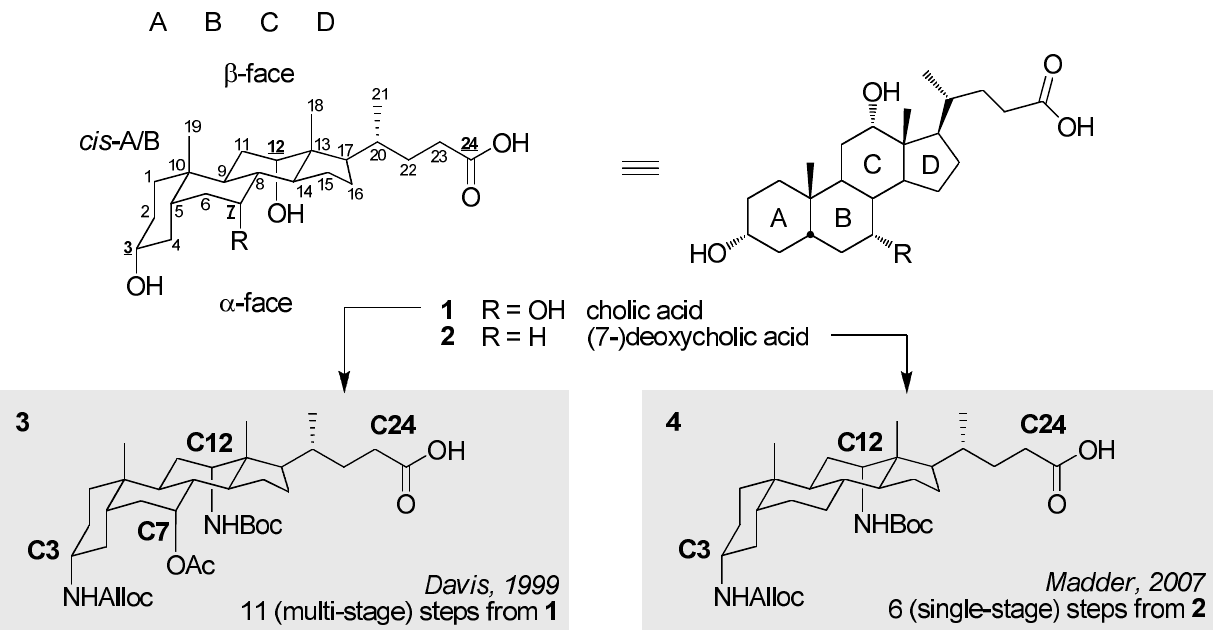
Figure 1. Selection of natural bile acids and related synthetic amino derivatives relevant for current